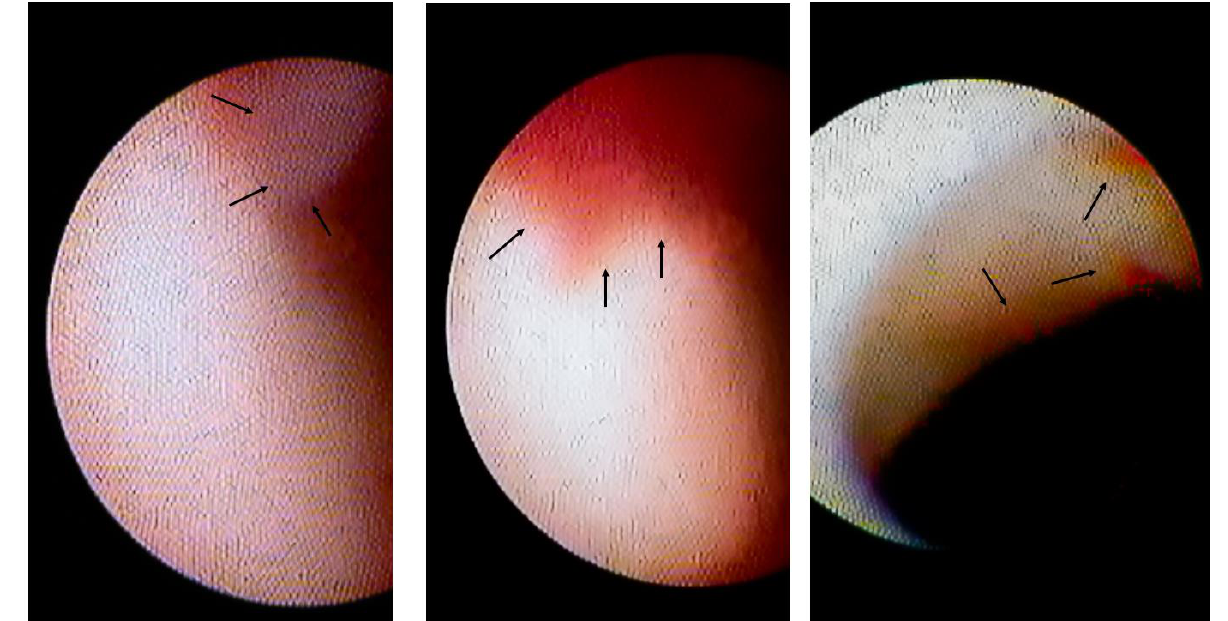
Figure 2. Intracoronary thrombi in VSA patients. The left panel shows the white thrombus (indicated by arrows) on the erosion-like red thrombus. The centre panel shows the erosion-like red thrombus, indicated by arrows. The right panel shows several erosion-like red thrombi, indicated by arrows.